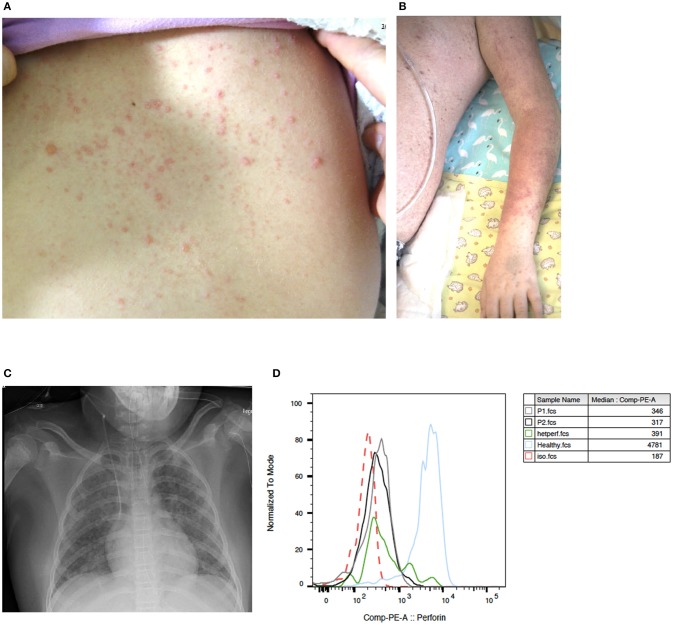
Clinical presentation of VZV disease in GATA2-haploinsufficient patient (A) An erytematous, vesicular skin rash on the back of patient 1 with GATA2-haploinsufficiency, 4 days after the onset of VZV disease. (B) Targetoid lesions on the left arm of the same patient, 7 days after the onset of illness. (C) A chest X-ray 8 days after the onset of illness, showing diffuse alveolar involvement with a miliary pattern of pulmonary opacities. (D) Histograms showing perforin expression in CD56+CD16+ lymphocytes from patient 1 (gray), patient 2 (black), an individual with heterozygous A91V PRF1 mutation (green), a healthy control (blue) and isotype control (red dotted line) as assessed by intracellular flow cytometry.